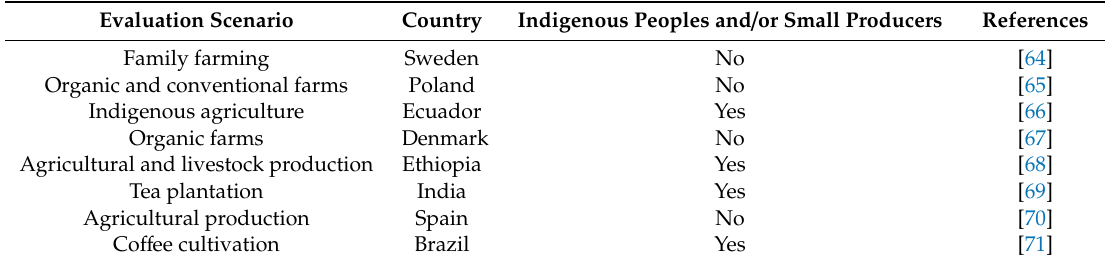
Table 1. Evaluation of sustainability using the response-inducing sustainability evaluation (RISE)